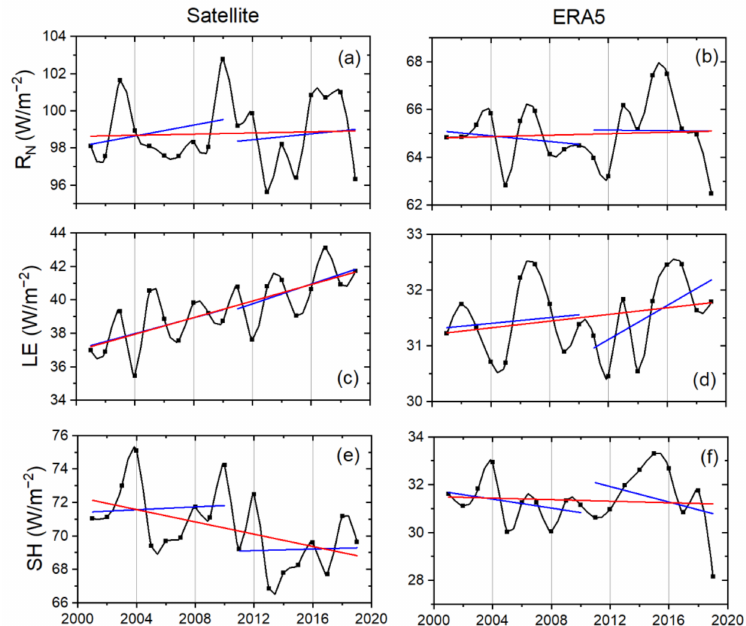
Figure 5. Temporal variation of R N , LE, and SH based on aerial average over TP. ( a , c , e ) represent trends observed from satellite data while the ( b , d , f ) represents trends observed from ERA5 data. Decadal trends are shown in blue and overall temporal trend from 2001–19 is shown in